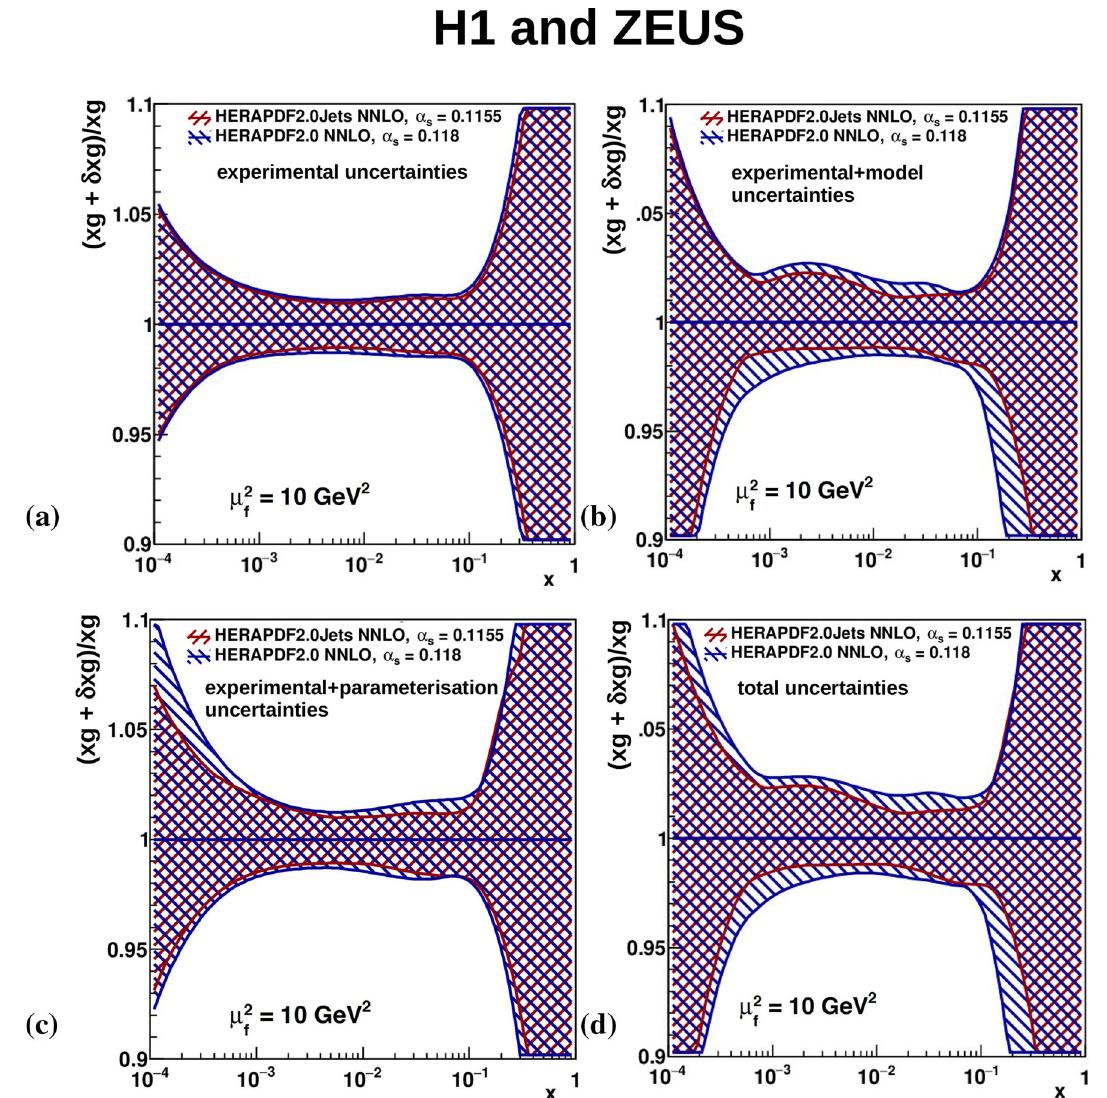
Fig. 10 ComparisonofthenormaliseduncertaintiesonthegluonPDFs a experimental (fit), b experimental plus model, c experimental plus ) = 0 . 1155 and HERAPDF2.0 of HERAPDF2.0Jets NNLO for α s ( M 2 parameterisation, d total uncertainties. The uncertainties on both gluon Z ) = 0 . 118, both at the scale μ 2 = 10GeV 2 , for PDFs are shown as differently hatched NNLO for α s ( M 2 Z f